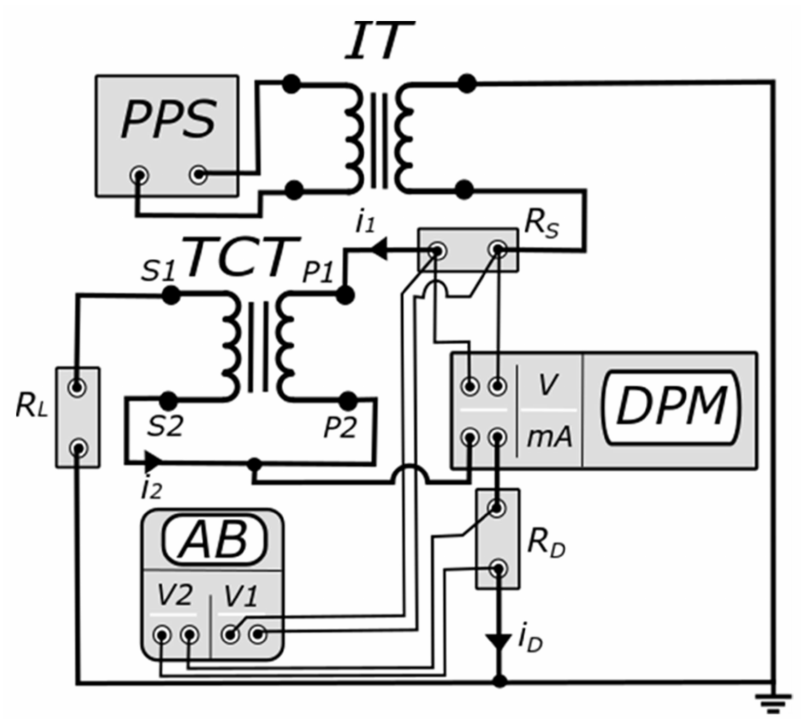
Figure 1. Measuring circuit for the determination of current and phase errors of higher harmonics transformation. In Figure 1, the following abbreviations are used: AB —digital acquisition